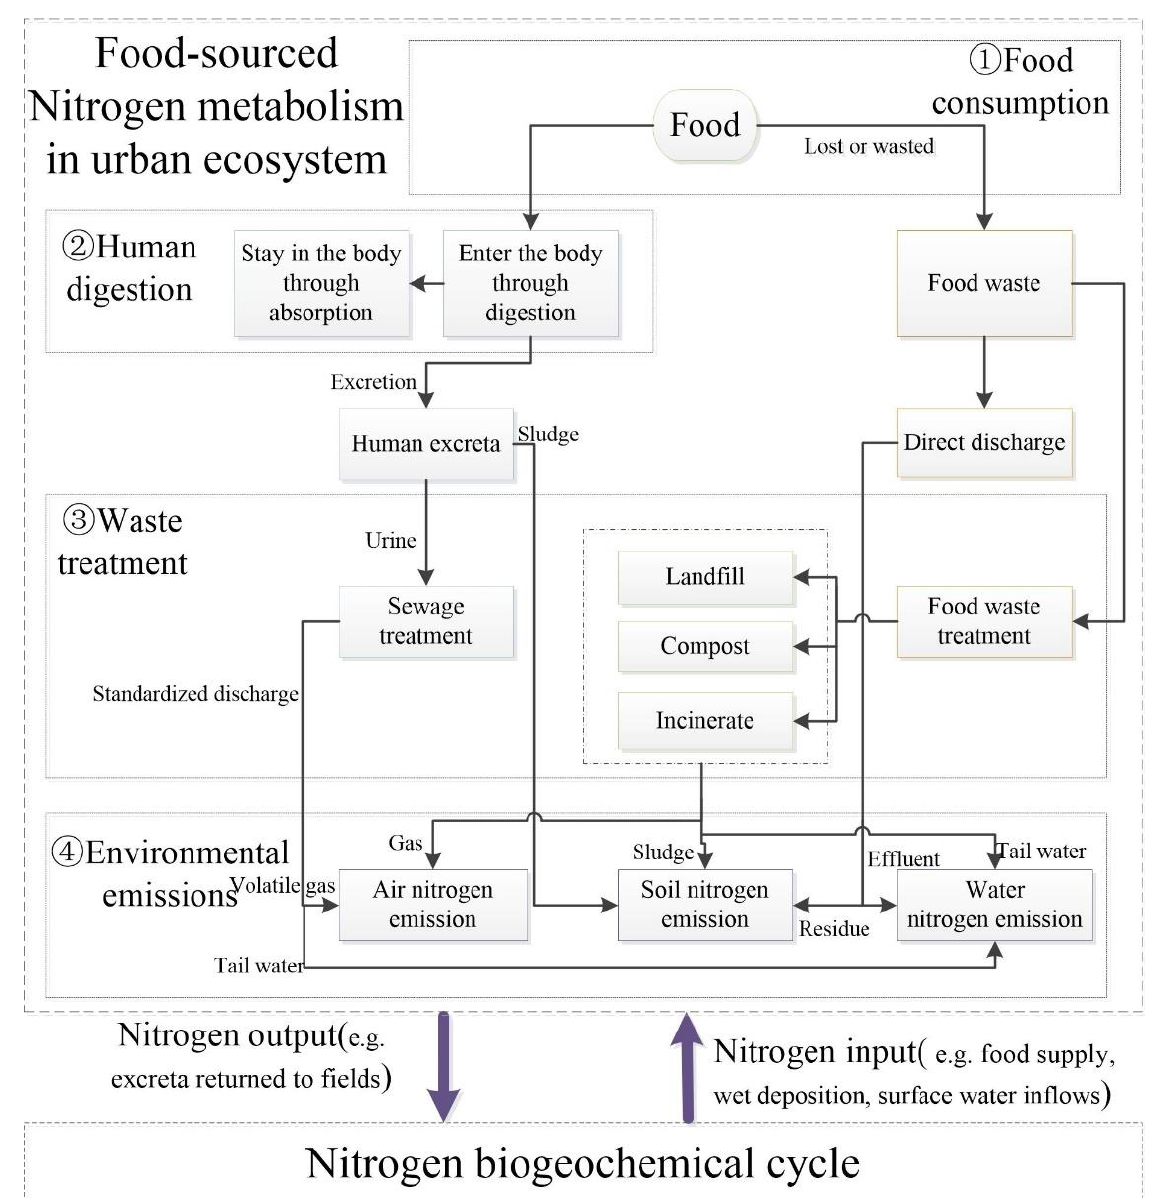
Figure 2. Flow path diagram of urban metabolism of food-sourced nitrogen.